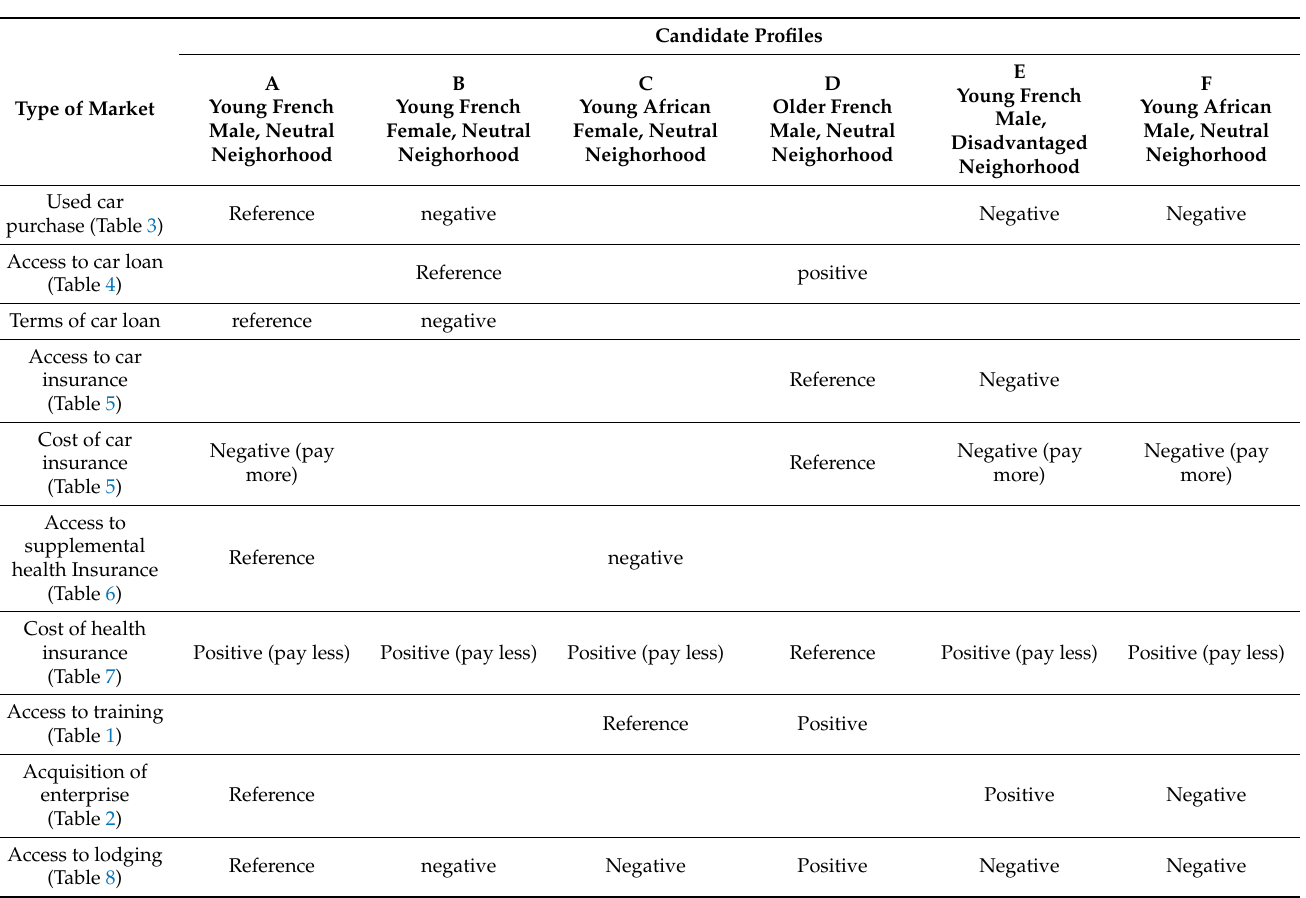
Table A5. Summary of discrimination